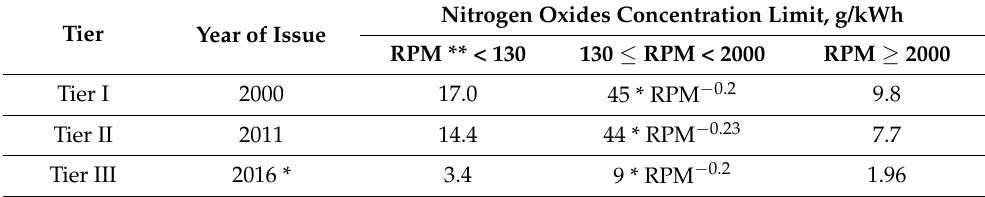
Table 2. NO x emission limits from marine engines that have issued by IMO according to MARPOL Annex VI. (Table was genuinely generated using data from ref.